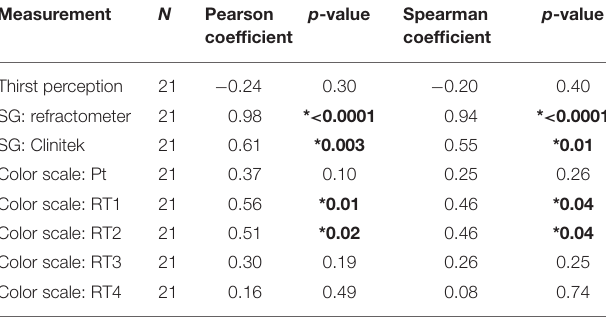
TABLE 1 | Correlations between hydration markers and urine osmolality.